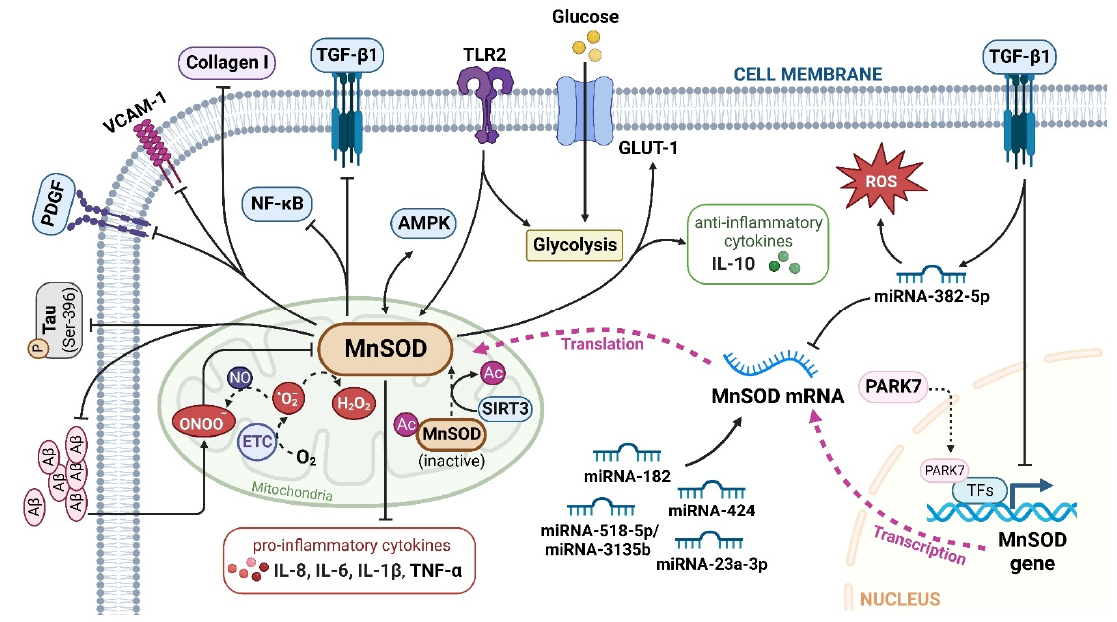
Figure 2. The major signalling pathways involved in MnSOD regulation. MnSOD is localized in the mitochondrial matrix to catalyse the dismutation of O2 •− to H2O2, and regulate cellular redox homeostasis. Multiple factors, cytokines, proteins, and miRNAs have been involved in the transcriptional and translational modulation of MnSOD. TGF-β1, transforming growth factor-β1; TLR2, toll-like receptor 2; Aβ, amyloid, β-protein; GLUT-1, glucose transporter member 1; IL, interleukin; VCAM-1, vascular cell adhesion molecule-1; AMPK, adenosine 5′-monophosphate-activated protein kinase; P, phospho; PDGF, platelet-derived growth factor; NF-κB, nuclear factor kappa-B; ETC, electron transport chain; PARK7, Parkinson disease protein 7; TFs, transcriptional factors; Ac, acetyl; SIRT3, sirtuin 3. ‘ ↑ ’ represents increased or upregulated, while ‘ ⊥ ’ represents suppressed or downregulated (created with BioRender.com (accessed on 4 November 2022)).